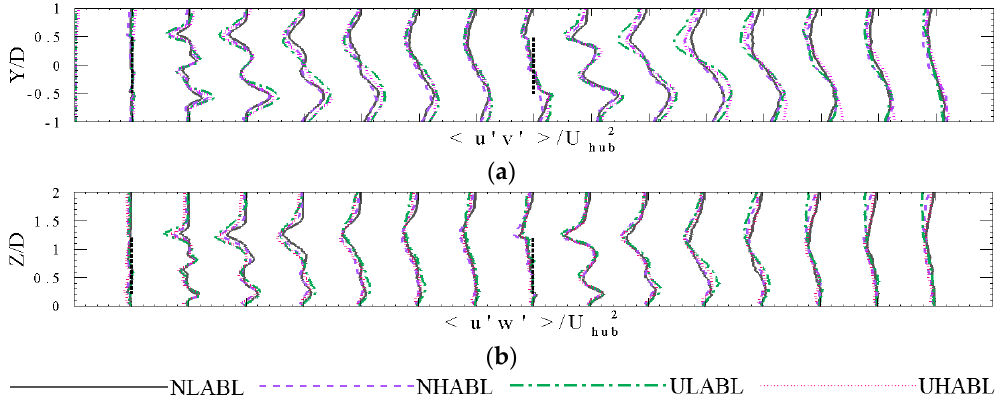
Figure 10. Reynolds shear stress for ( a ) horizontal profiles of <u’v’> and ( b ) vertical profiles of <u’w’> normalized by the mean velocity at hub-height (8 m/s). Turbines positions are indicated with black dashed-lines.